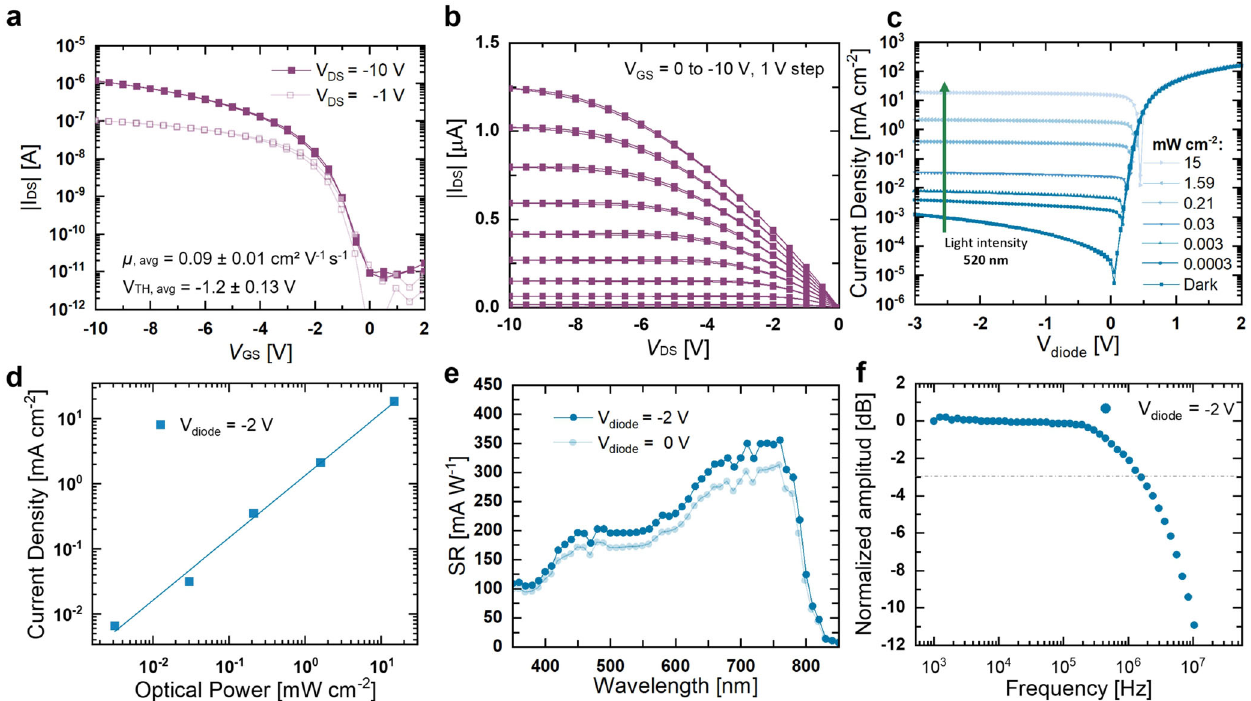
Fig. 2 Characteristics of individual OTFTs and OPDs. a Transfer characteristics of the individual transistors measured after integration. b Output characteristics of the individual transistors measured after integration. c J-V characteristics of the photodiodes measured after integration. The measurements were performed at different light intensities (as reported in mW cm − 2 ) and with a monochromatic light source ( λ = 520 nm). d Devices response for different light intensities at − 2 V. An LDR value of 89 dB was obtained. e Spectral responsivity of the device at 0 and − 2 V. The peak responsivity reaches a value of 356 mAW − 1 at − 2 V. f Cut-off frequency measurement at − 2 V. The 3 dB cut-off frequency reaches a value above 1